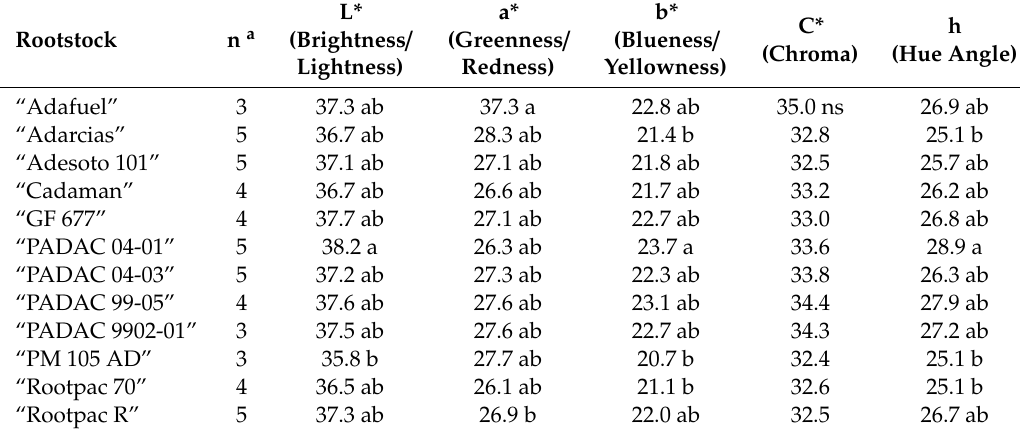
Table 7. Rootstock e ff ect on the chromatic parameters of “Big Top” fruits on twelve rootstocks during